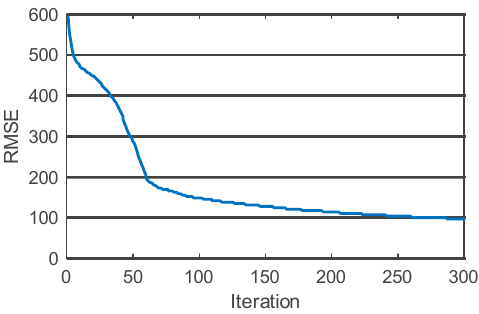
Figure 17. Training progress of the CNN+LSTM.